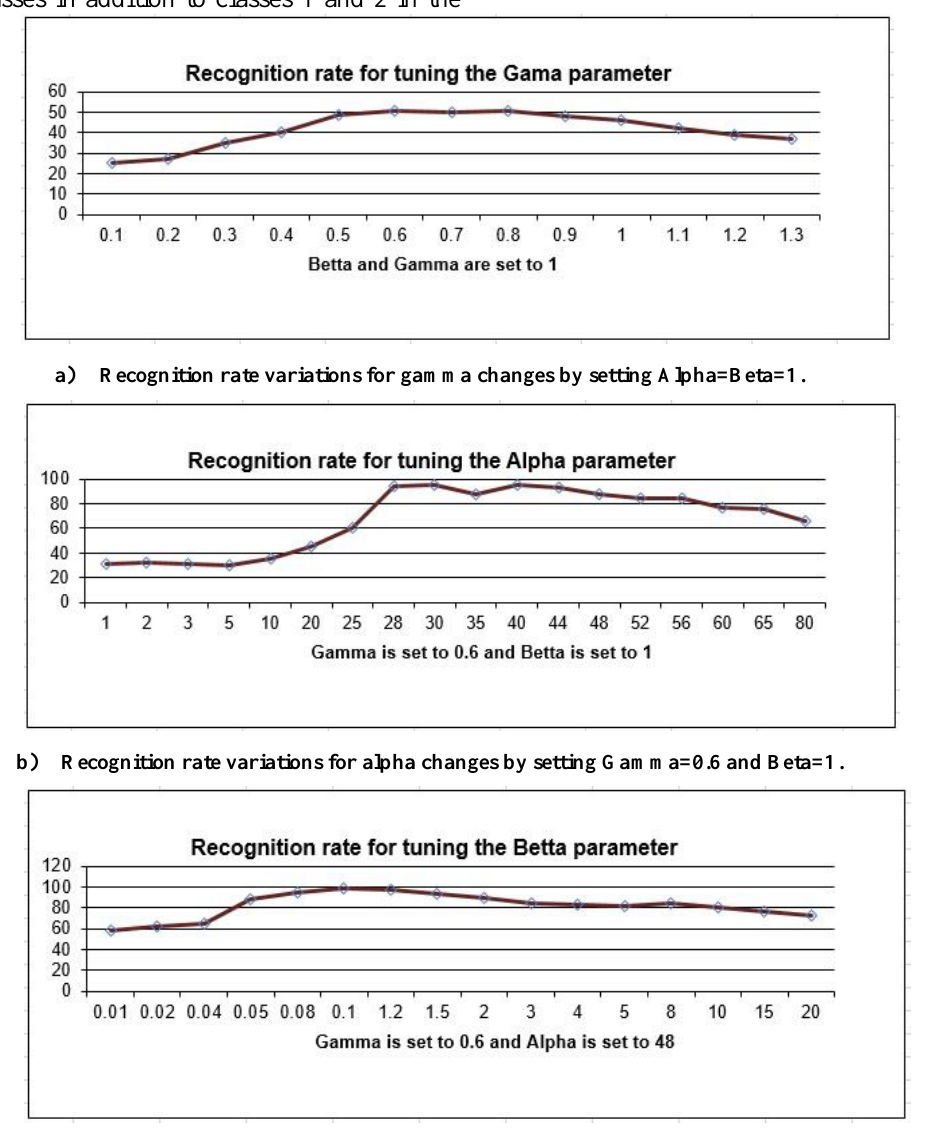
Figure 5. The parameters setting using ORL